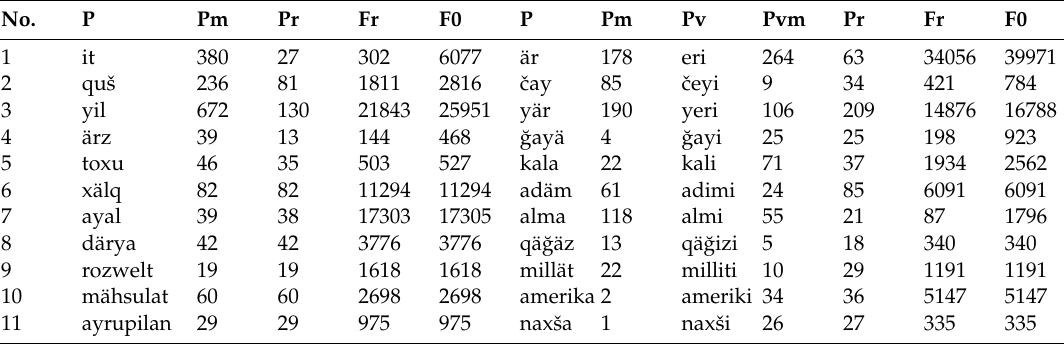
Table 2. Statistics of experimental words in the corpus type B.